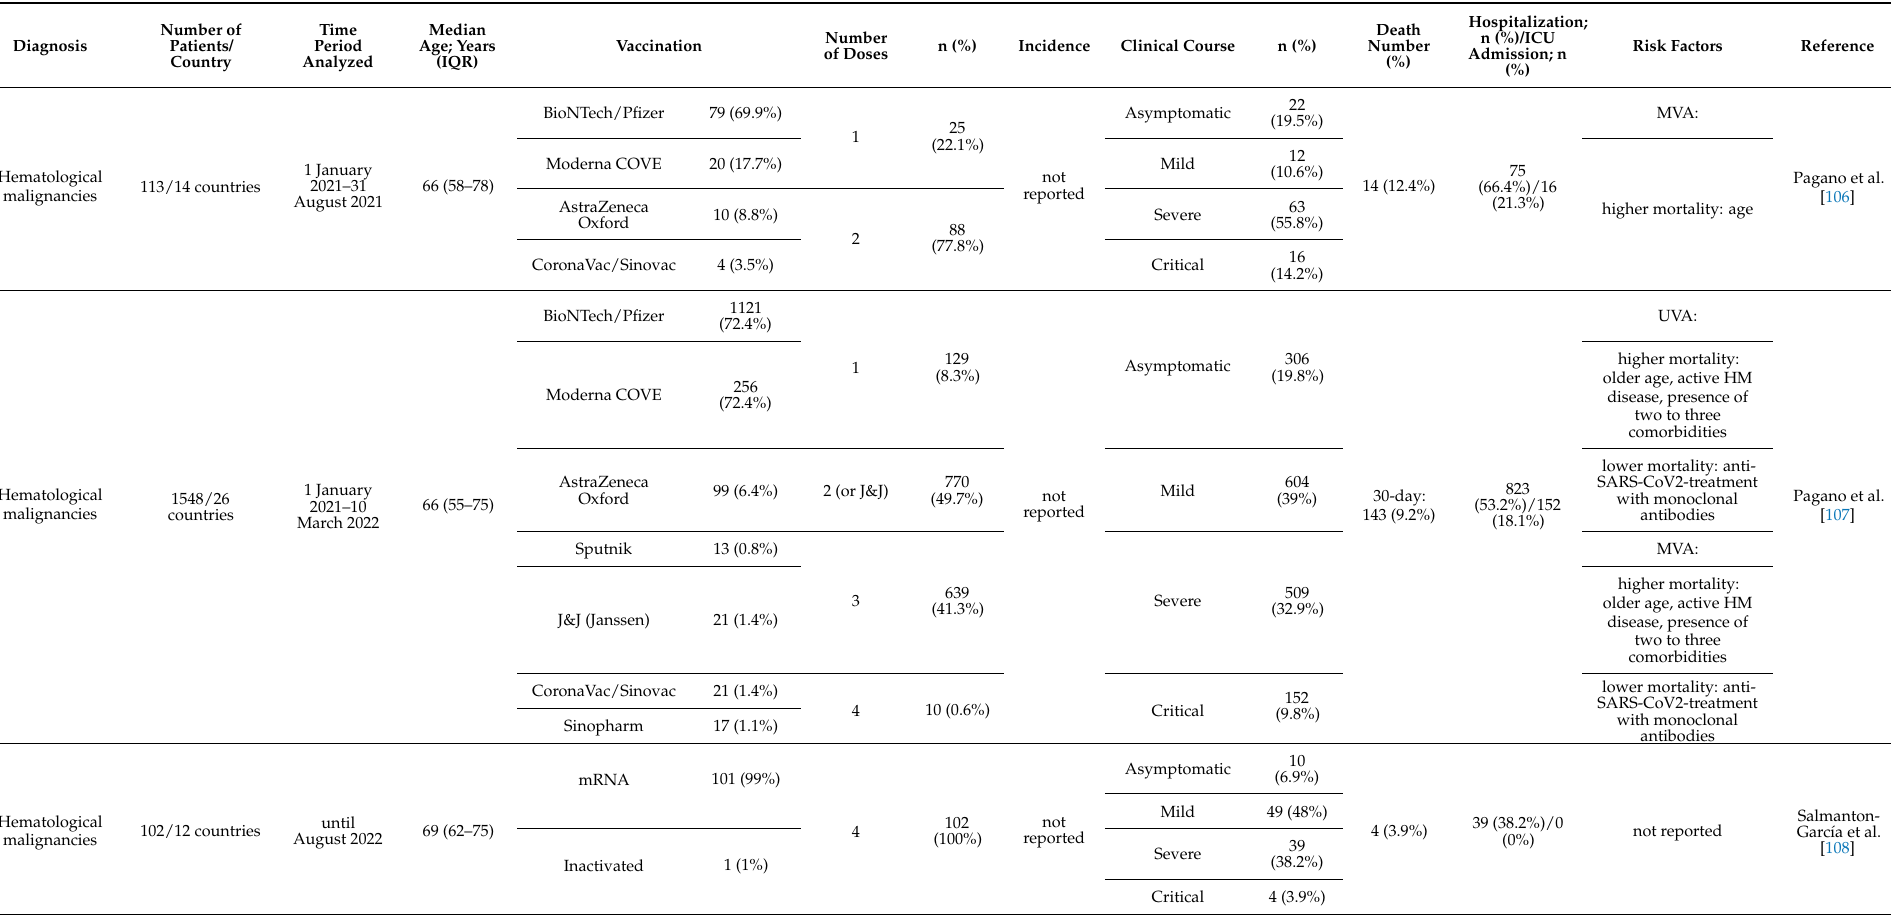
Table 2. COVID-19 vaccines used both as primary vaccination and booster approved in European Union countries and their clinical efficacy in cancer patients. Number of Time Median Diagnosis Patients/ Period Age; Years Vaccination n (%) Incidence Clinical Course n (%) Analyzed (IQR)